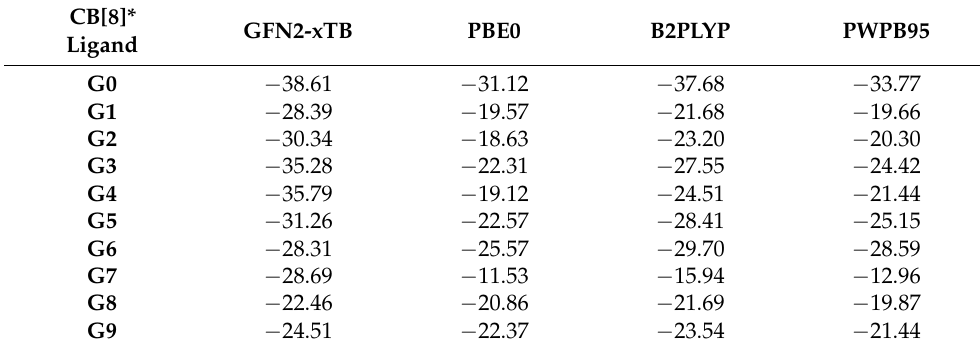
Table 4. Energies of association (E a ) of GFN2-xTB and DFT calculations for top-ranked CB[8]*G0– G1 ligand-receptor complexes in